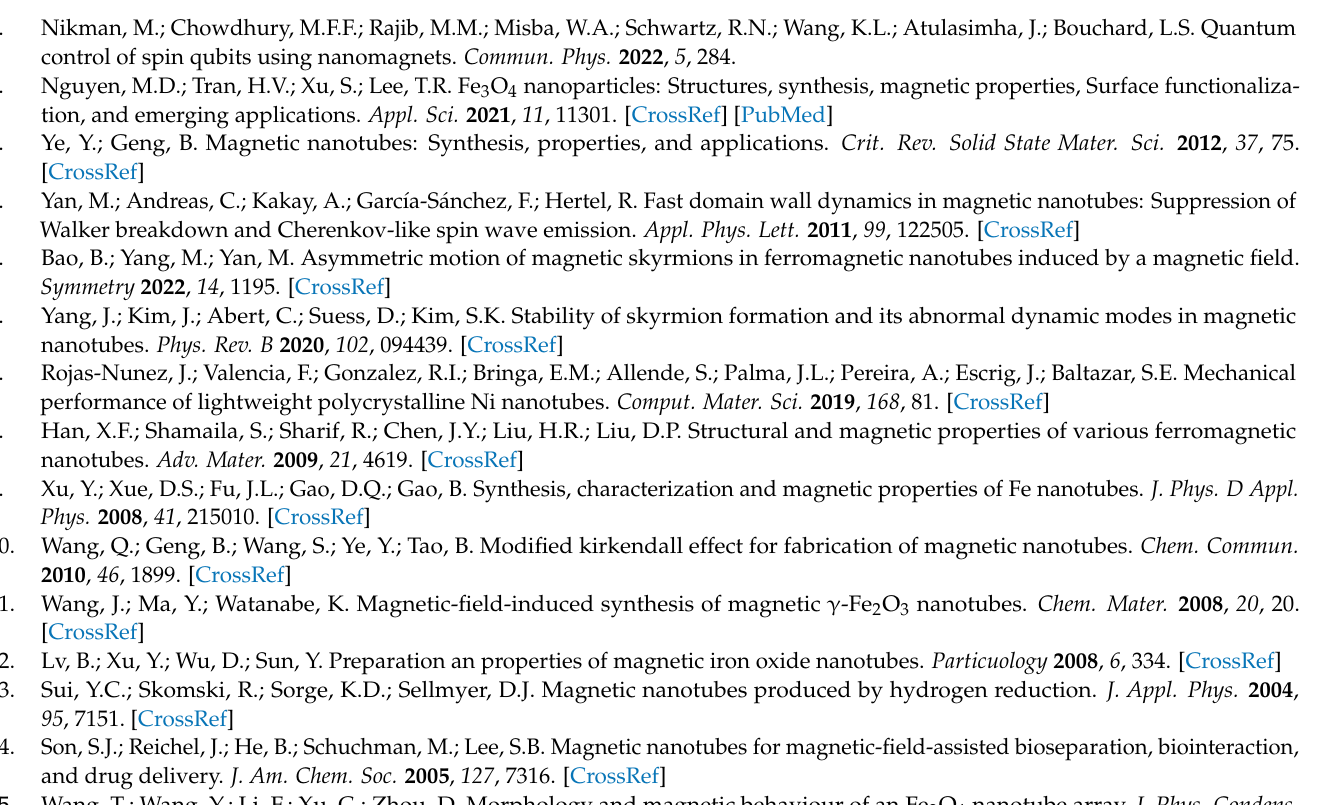
Figure A5. Dynamic susceptibility spectra for 1000 nm long Fe 3 O 4 nanotubes with different radii ranging between 30 and 80 nm, for different β values, while the system is excited with a sinc wave field in the y -direction.